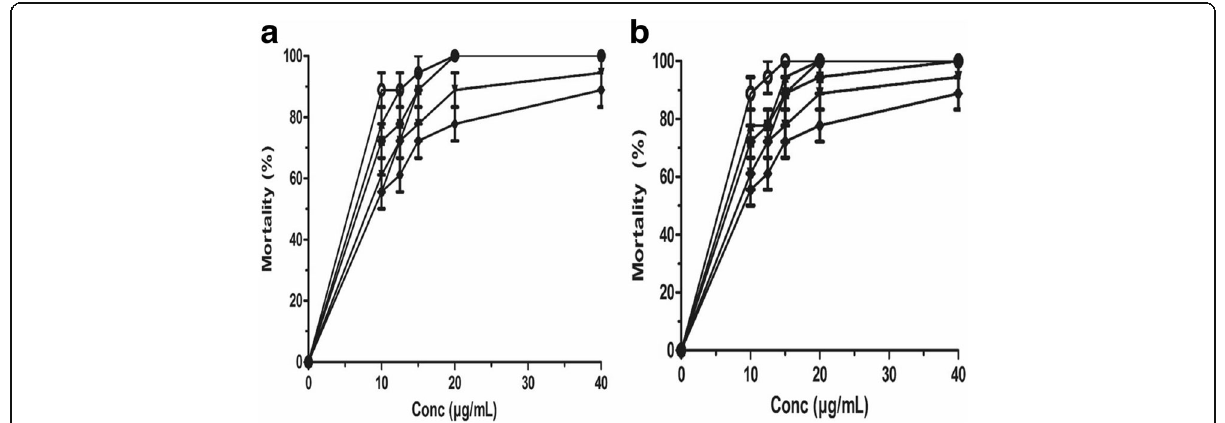
Fig. 1 Activity against O. ochengi with ( a ) crude ethanolic and ( b ) MeOH-CH 2 Cl 2 extracts from L. lanceolata ( ● ) leaves, ( ■ ) trunk bark, ( ▲ ) root bark; ( ▼ ) Levamisole, ( ♦ ) Albendazole and ( ○ ) Ivermectin 72 h post-exposure. Data are mean ± SEM from three independent duplicate